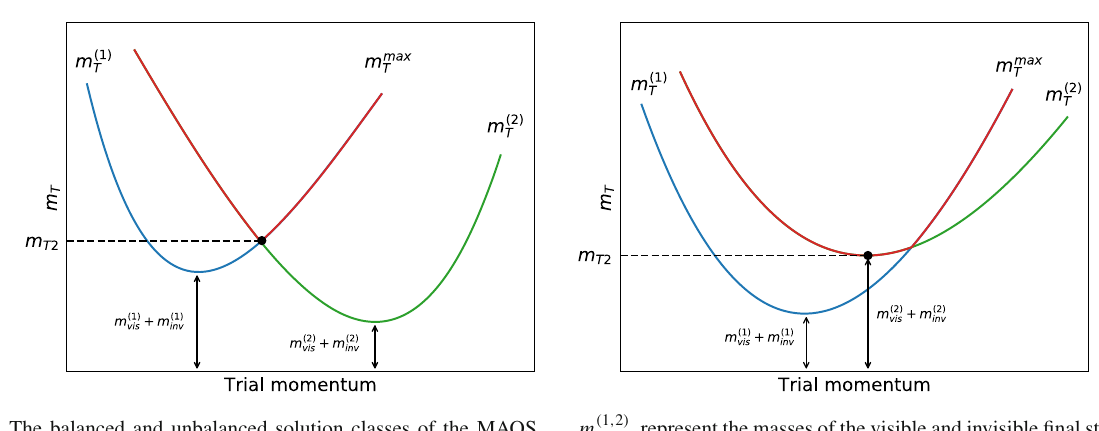
Fig. 4 The balanced and unbalanced solution classes of the MAOS minimization problem. The two transverse masses m of the trial momenta are shown in blue and green and the resulting func- tional m max is shown in red. In the balanced case (left) the solution m T2 T is in the intersection of the two m T curves and in the unbalanced case (right) the m T2 is in one of the minima of the m T curves. The m